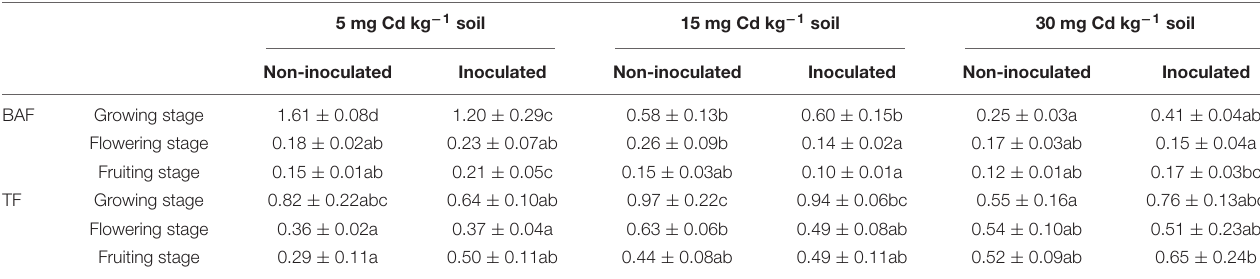
TABLE 3 | Effects of the endophyte (FZT214) inoculation on bioaccumulation factor (BAF) and translocation factor (TF) (mean ± STD, n = 3) of D. ambrosioides grown under different Cd concentrations at different developmental stages (growing, flowering, and